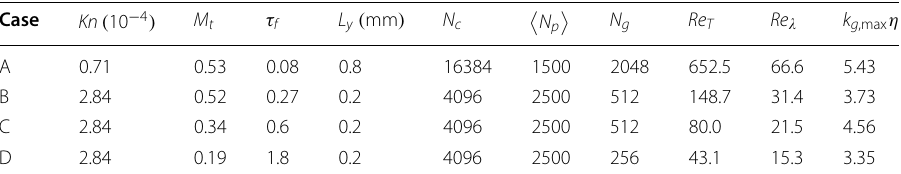
ρ 300K and 1.6kg / m 3 T � � = � � =